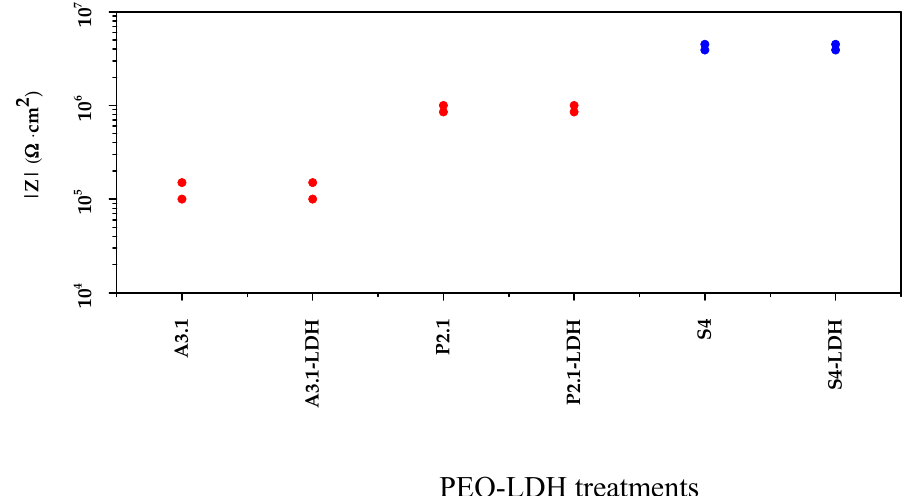
Figure 9. Scatter diagram of impedance modulus at 10 − 2 Hz; selected PEO-LDH coatings on AA1050 alloy.